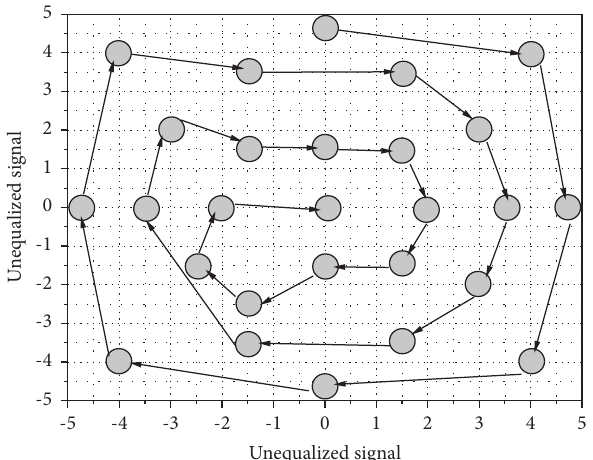
Figure 10: Simulation results of the high-speed hydroacoustic OFDM communication system based on unbalanced Turbo codes.